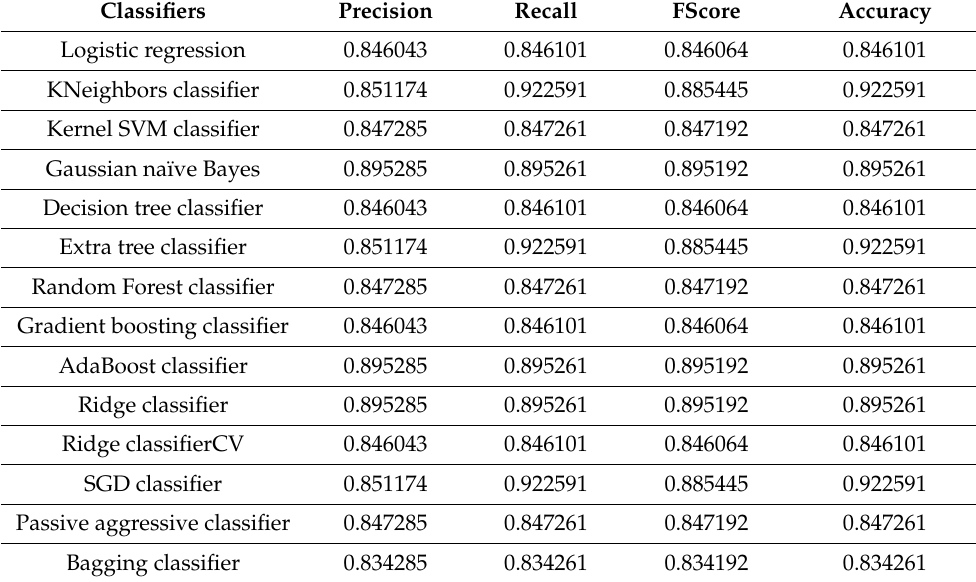
Table 14. Extra trees regressor metrics after feature scaling.